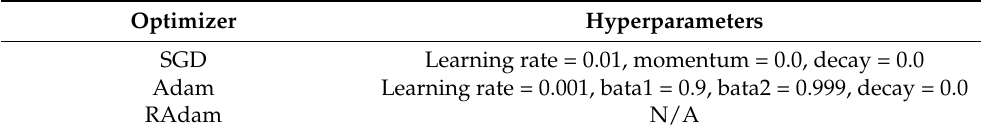
Table 3. Hyperparameters given to each